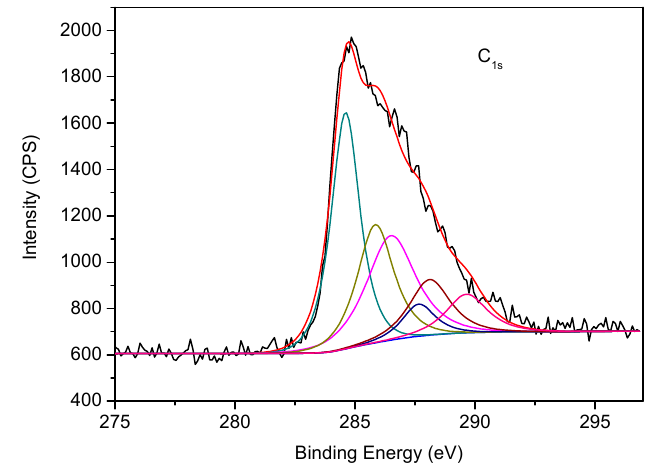
Figure 3. High-resolution C1s XPS spectra of 4.5EASSC sample.